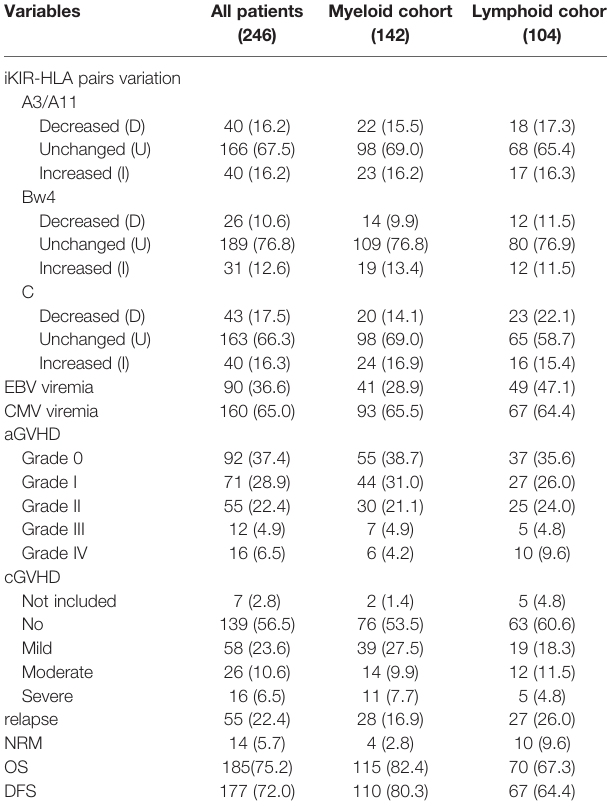
AML, acute myeloid leukemia; MDS, myelodysplastic syndrome; MPN, myeloproliferative neoplasm; ALL, acute lymphoblastic leukemia; MNC, mononuclear; CR1, fi rst complete remission; MAC, myeloablative conditioning; RIC, reduced-intensity conditioning; ATG, Antithymocyte Globulin; EBV, Epstein-Barr virus; CMV, cytomegalovirus; aGVHD, acute graft versus host disease; cGVHD, chronic graft versus host disease; NRM, non-relapse mortality; OS, overall survival; DFS, disease-free